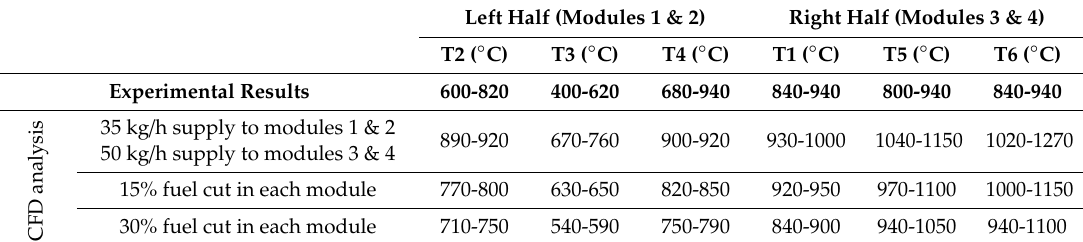
Table 2. Comparison of temperature at six points between measurement and